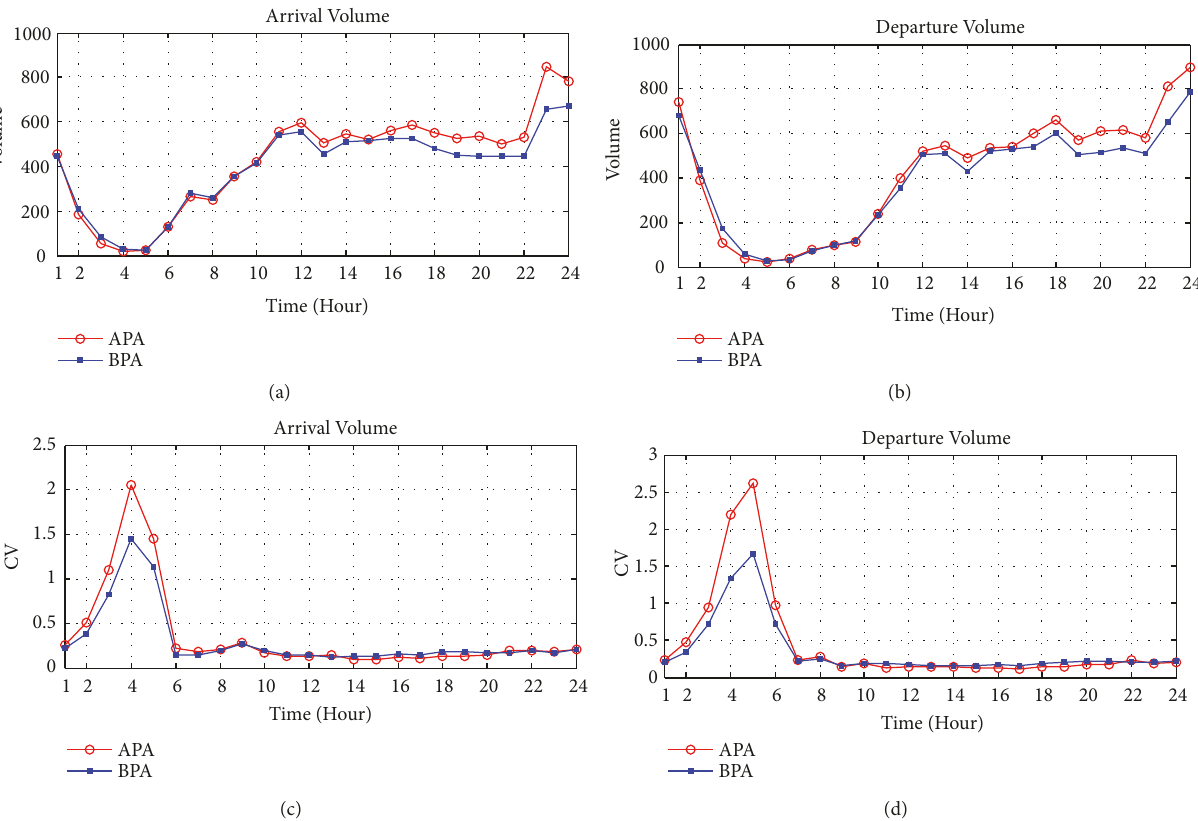
Figure 1: Comparison of parking demand before and after parking price adjustment: (a) parking demand; (b) exiting demand; (c) coefficient of variation of arrivals; (d) coefficient of variation of